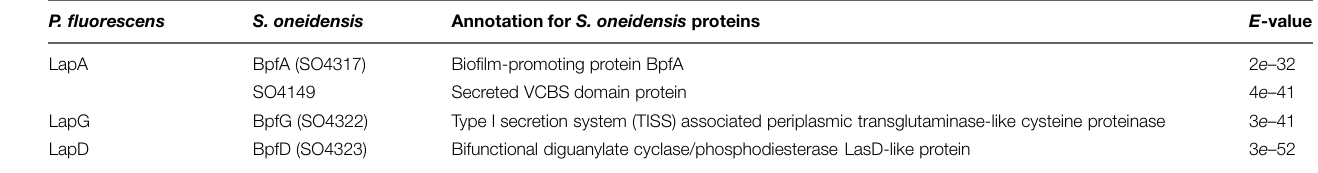
TABLE 1 | BlastP results of Pseudomonas fluorescens LapA, LapG, and LapD against Shewanella oneidensis. P.